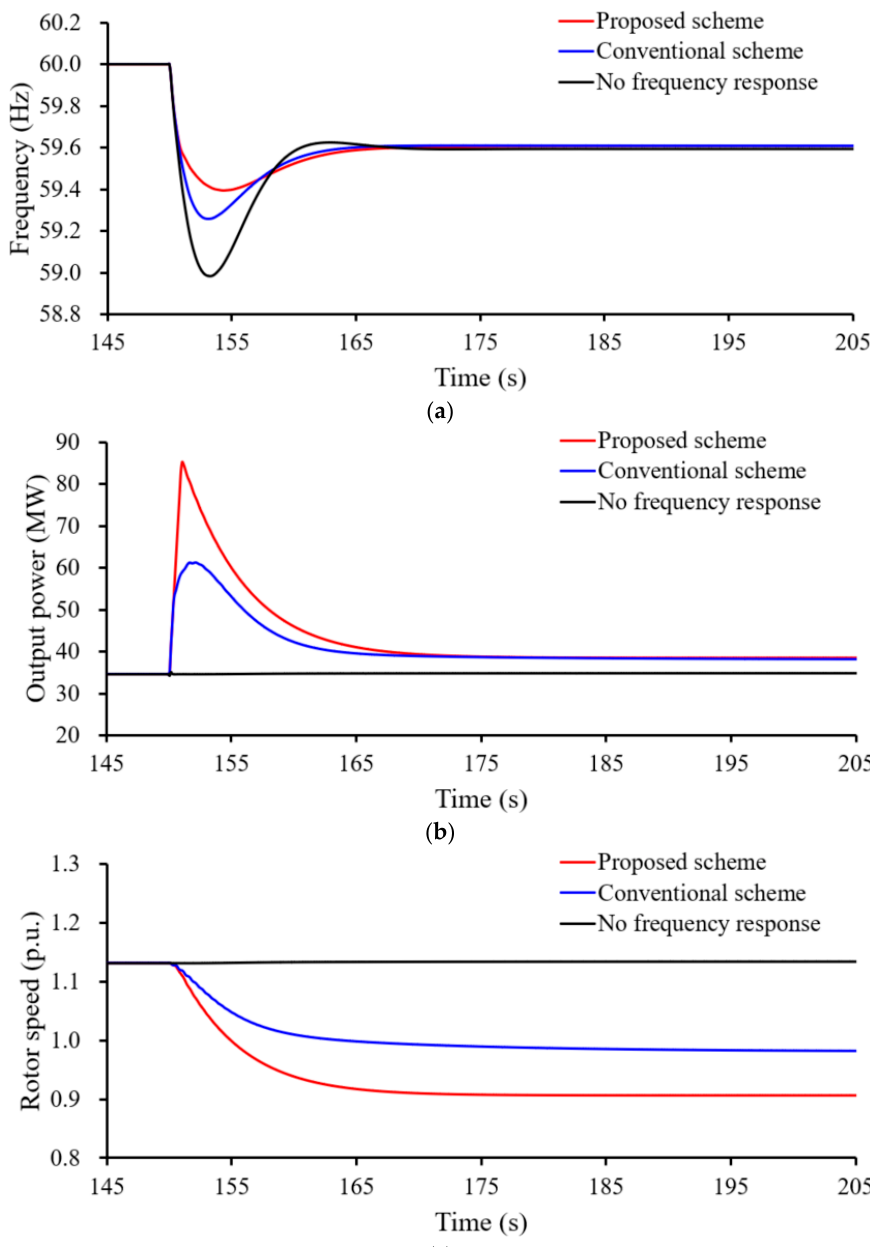
Figure 10. Results for Case 1 : ( a ) Frequency; ( b ) Active power; ( c ) Rotor speed.